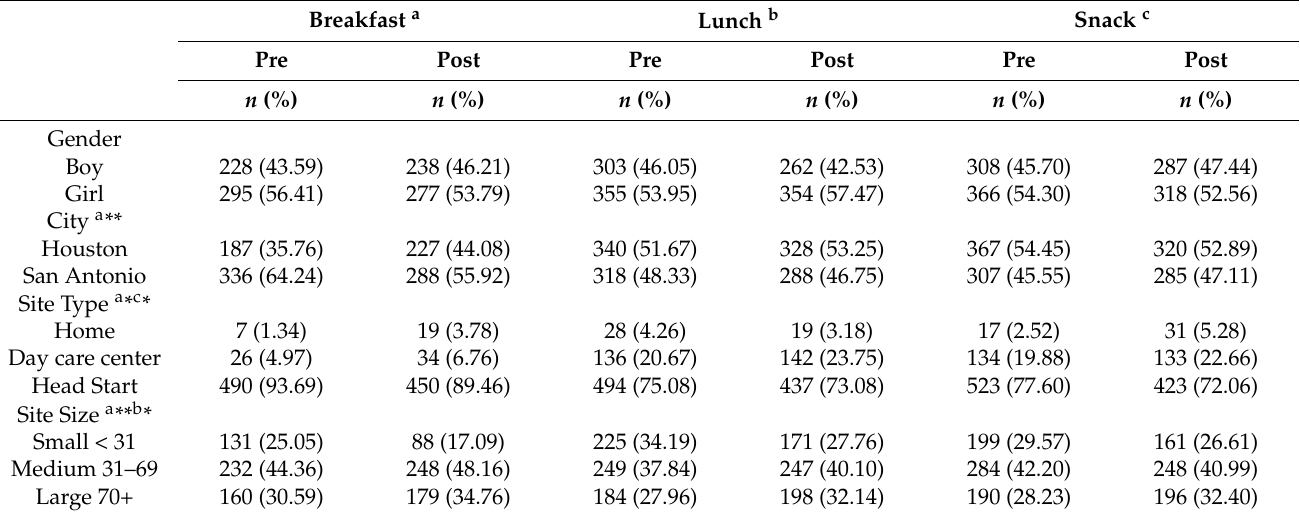
Table 1. Participant